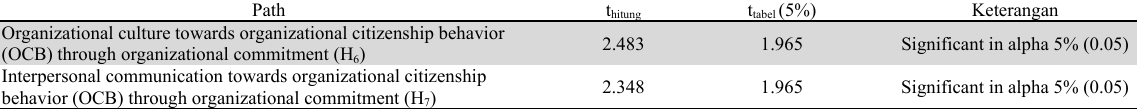
Sobel Test Results on the Effects of Mediation between Variables Path t hitung t tabel